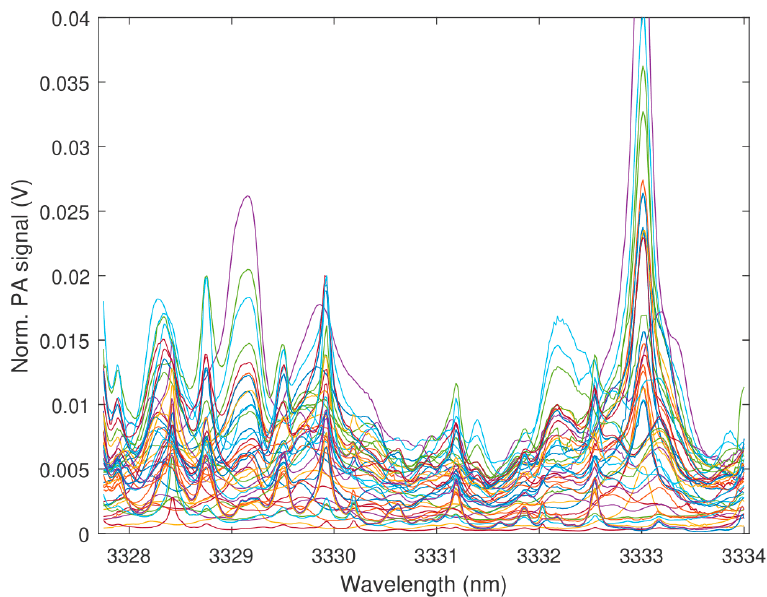
Figure A1. Measured PA spectra (43 different measurements) for multicomponent analysis with ICL 1541.